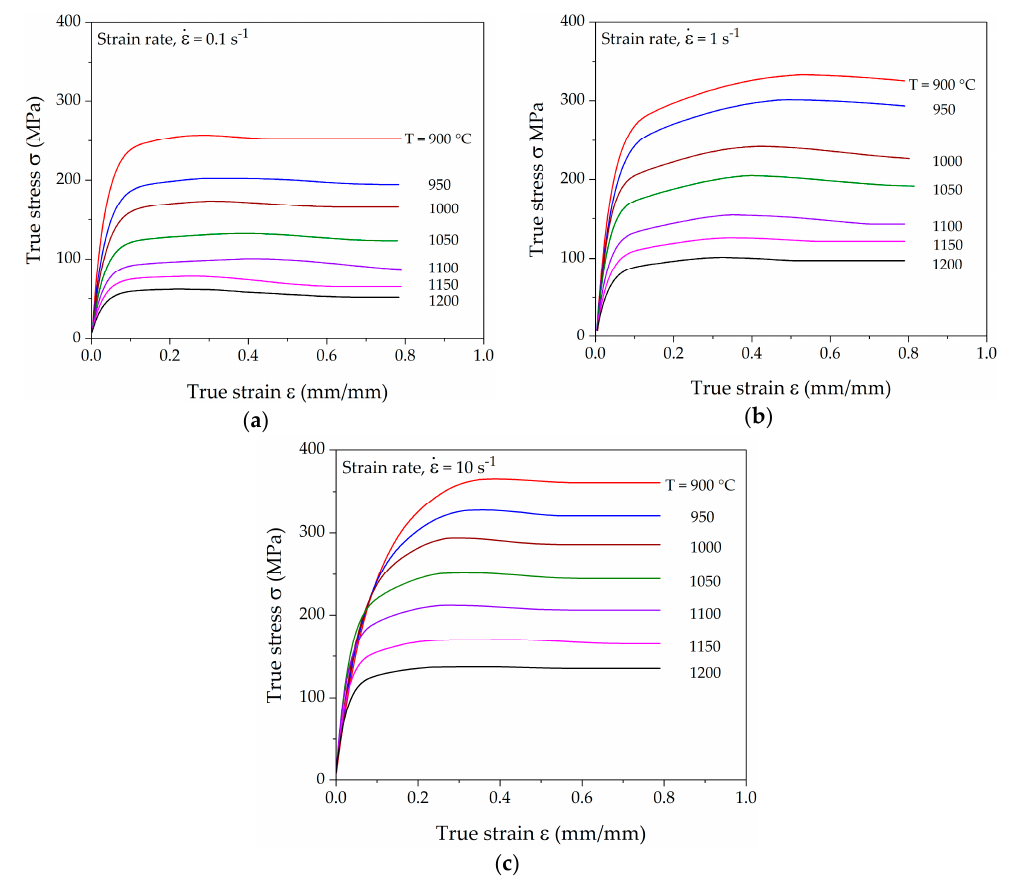
Figure 4. Representative true stress-strain curves for hot compression at different temperatures and strain rates of ( a ) 0.1 s − 1 ; ( b ) 1 s − 1 ; and ( c ) 10 s − 1 . strain rates of ( a ) 0.1 s − 1 ; ( b ) 1 s − 1 ; and ( c ) 10 s − 1